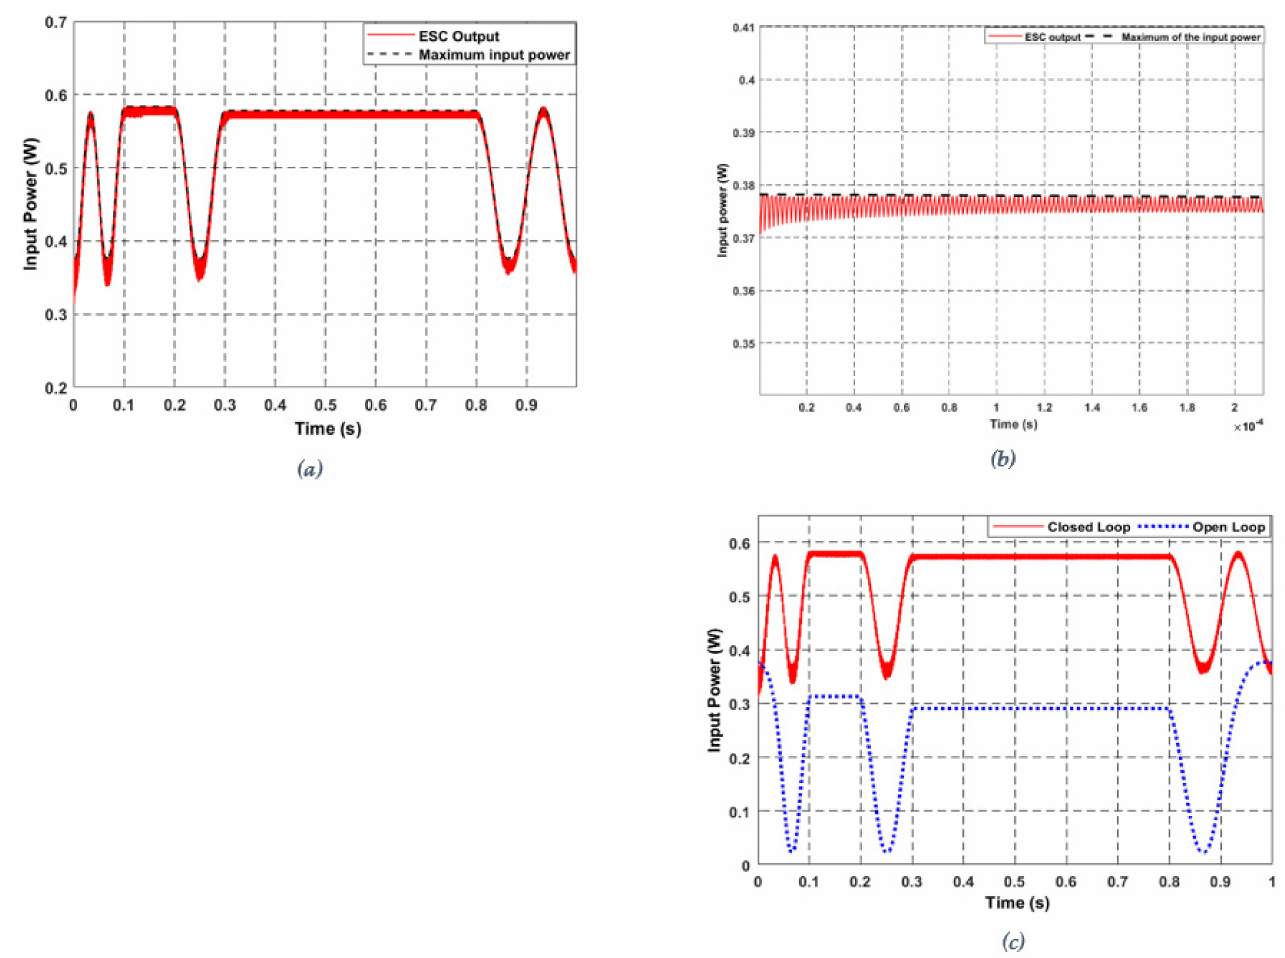
Figure 16. ( a ) Maximized input power response in the closed loop versus the calculated input power. ( b ) Zoomed view showing how the input power in the closed loop converges to the maximum. ( c ) Input power comparison between the closed loop and the open